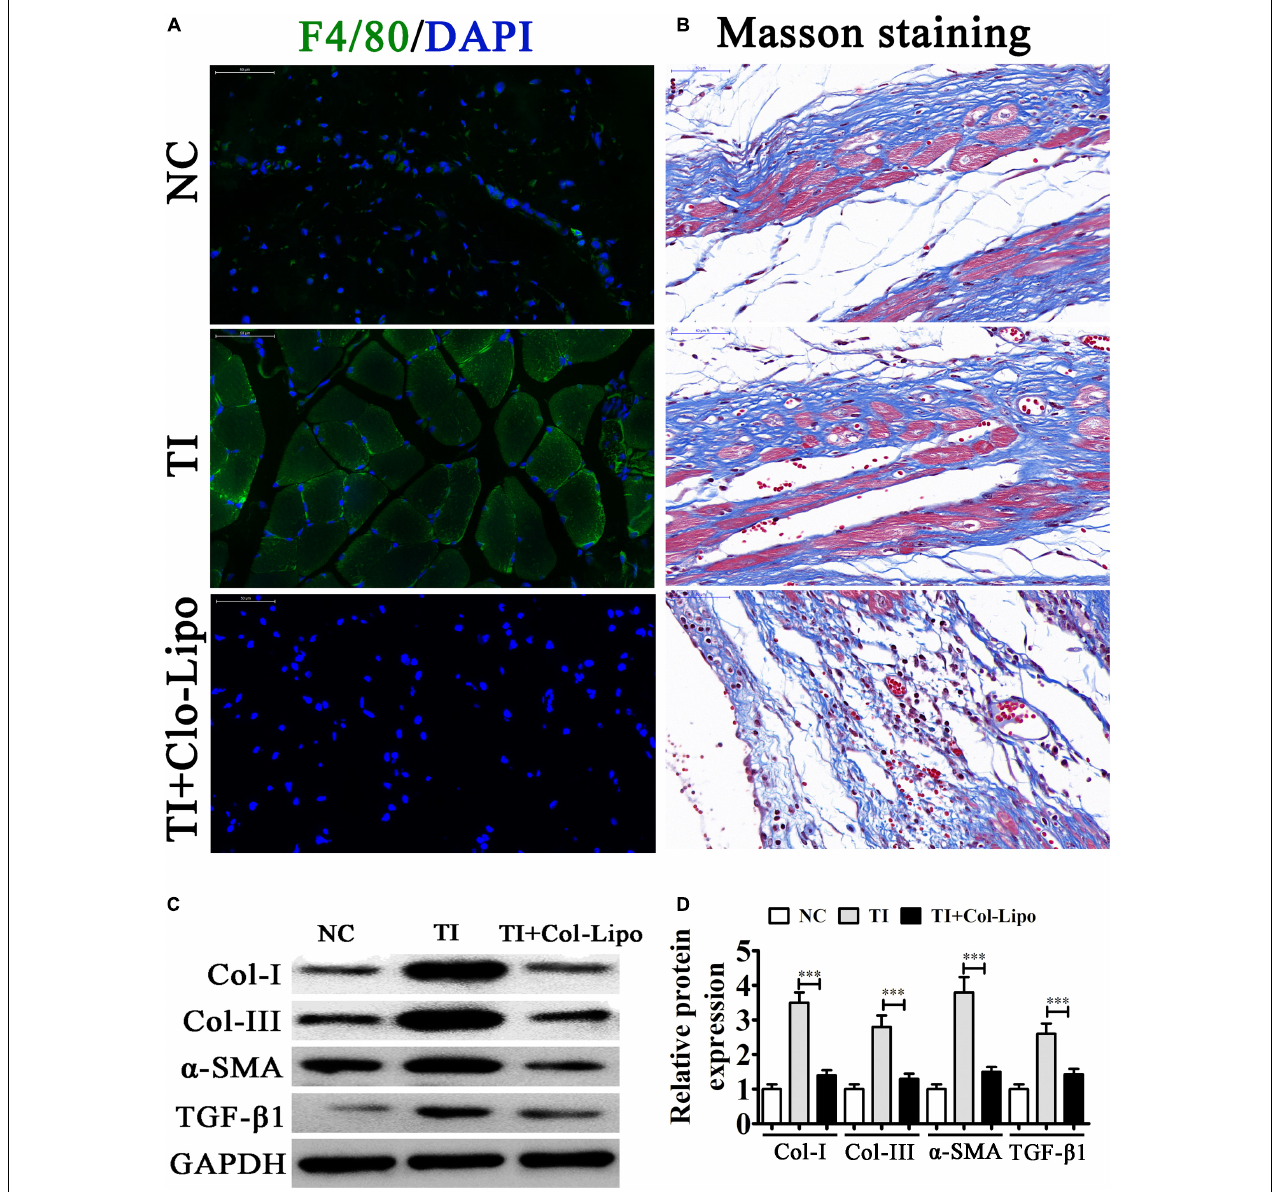
FIGURE 1 | Macrophages play an important role after tendon injury (TI) with or without Clo-containing liposomes. (A) Immunostaining of macrophages (F4/80 + cells were green) in each group; the cell nuclei were stained with 4,6-diamidino-2-phenylindole (blue). (B) Masson’s trichrome staining showing the fibrosis of tendon tissue. (C,D) Western blot analysis and quantification of the Col I, Col III, and α -SMA, as well as TGF- β 1 expression levels. The results are expressed as the mean ± SD, ∗∗∗ P < 0.001 vs. TI.